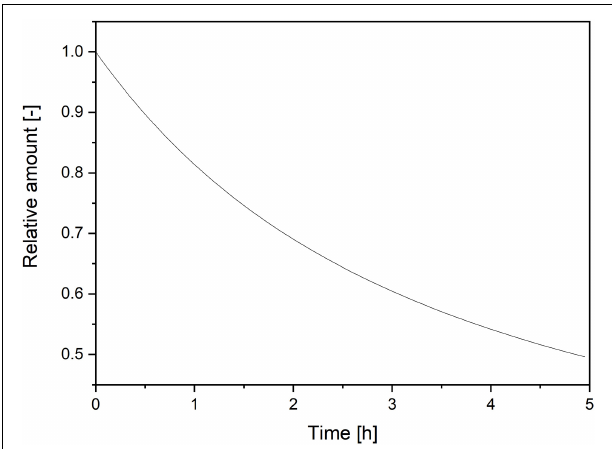
FIGURE 11 | Relative amount of fluid at the boundary of the cylinder plotted vs. time.